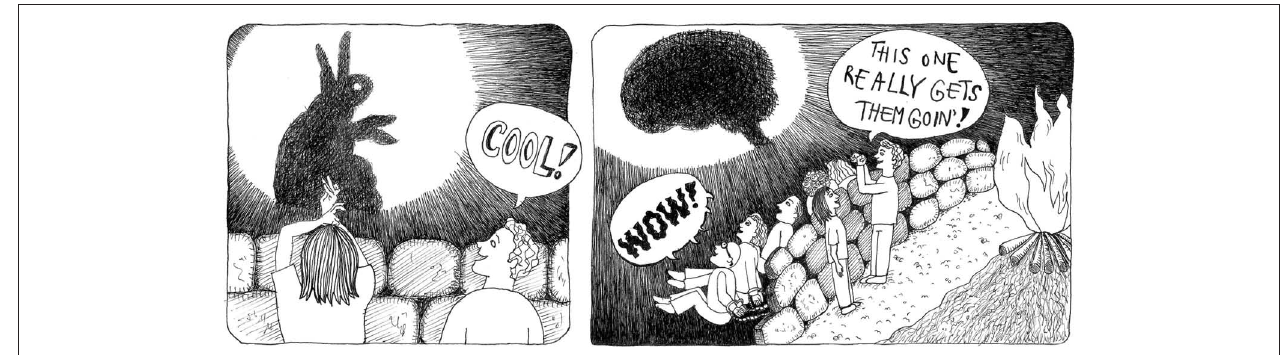
Figure 1 | Like prisoners in Plato’s cave, our view of the brain is shaped by how we measure it (i.e., the shadows cast by the flame). Drawing by Dr. Sanne de